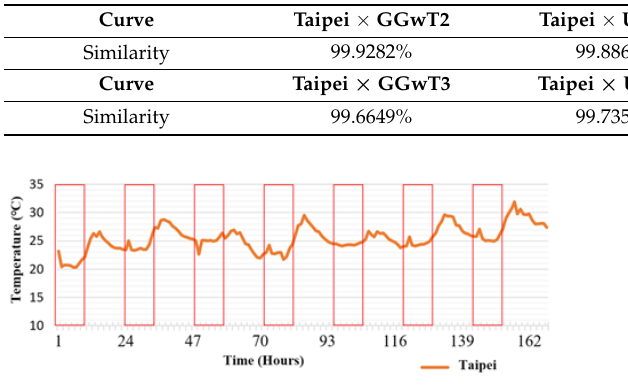
Figure 7. Time period used for calculating mean temperature differences.